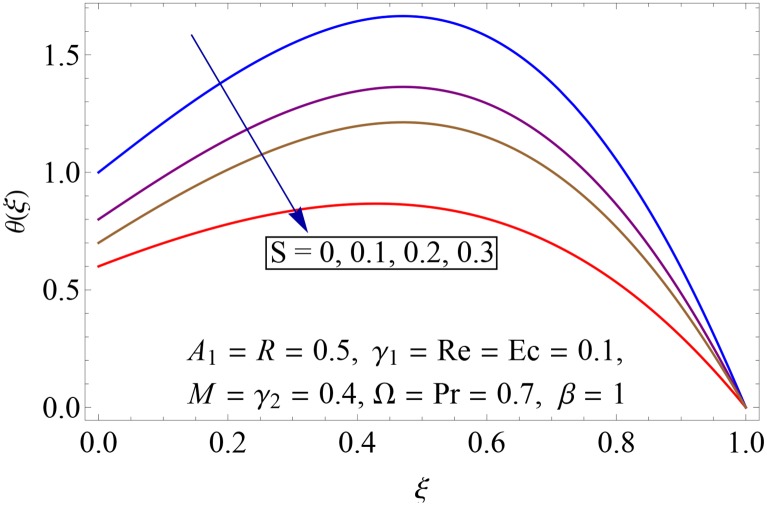
Impact of S on θ(ξ).